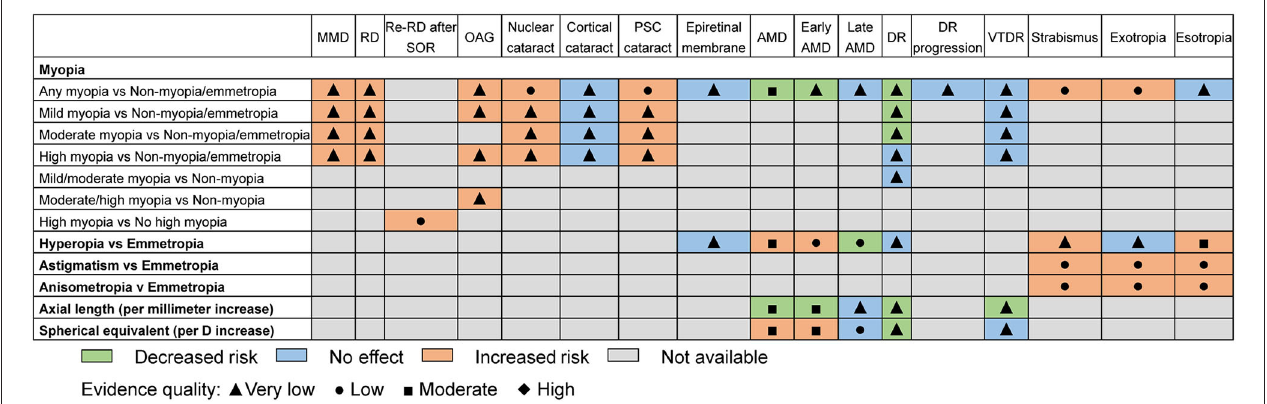
FIGURE 7 | Evidence map of refractive error with regard to eye health outcomes. MMD, myopic macular degeneration; RD, retinal detachment; Re-RD, retinal re-detachment; SOR, silicone oil removal; OAG, open angle glaucoma; PSC, posterior subcapsular; AMD, age-related macular degeneration; DR, diabetic retinopathy; VTDR, vision-threatening diabetic